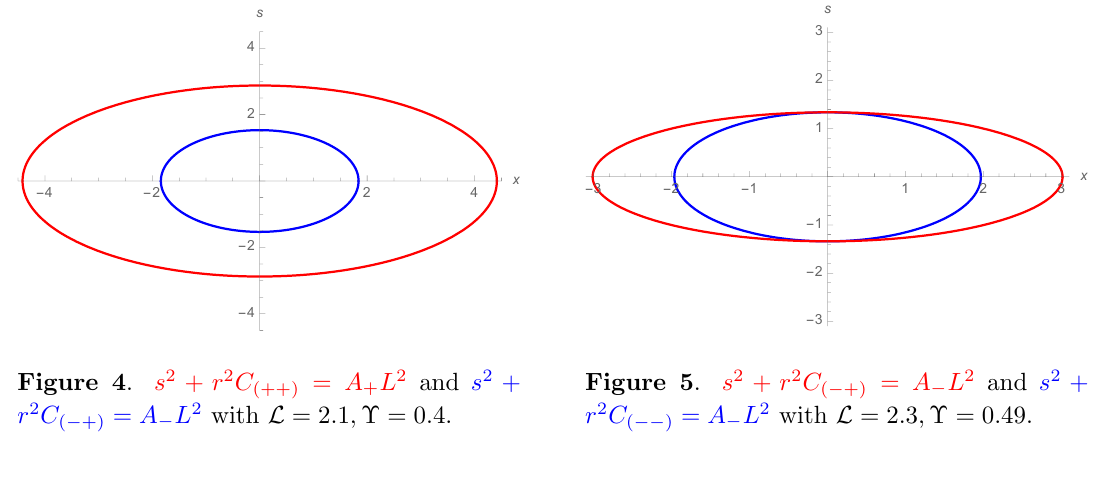
Figure 4 . s 2 + r 2 C = A + L 2 and s 2 + (++) r 2 C = A (cid:0) L 2 with L = 2 : 1 ; (cid:7) = 0 : 4. ( (cid:0) +)